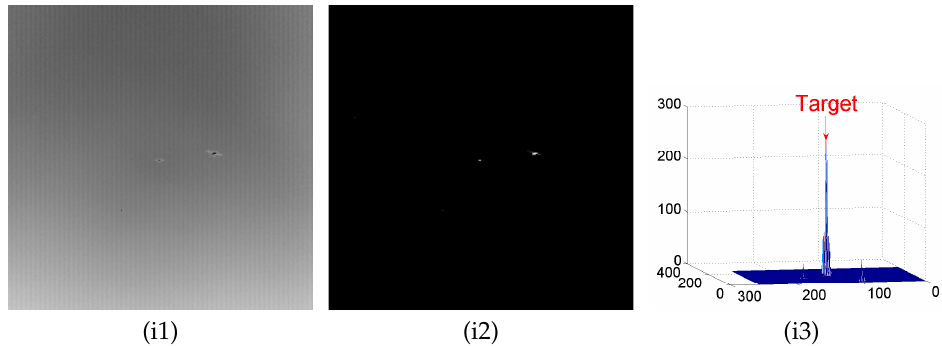
Figure A5. ( a – i) denote the detection results of the PSTNN, RPCA, TV-PCP, VNTFR, ASTTV, SRWS, C2, C3, and proposed algorithm on sequence F, respectively, where ( a1 – a3 ) denote the background map, the differential map, and the 3D map of the obtained differential map, respectively.